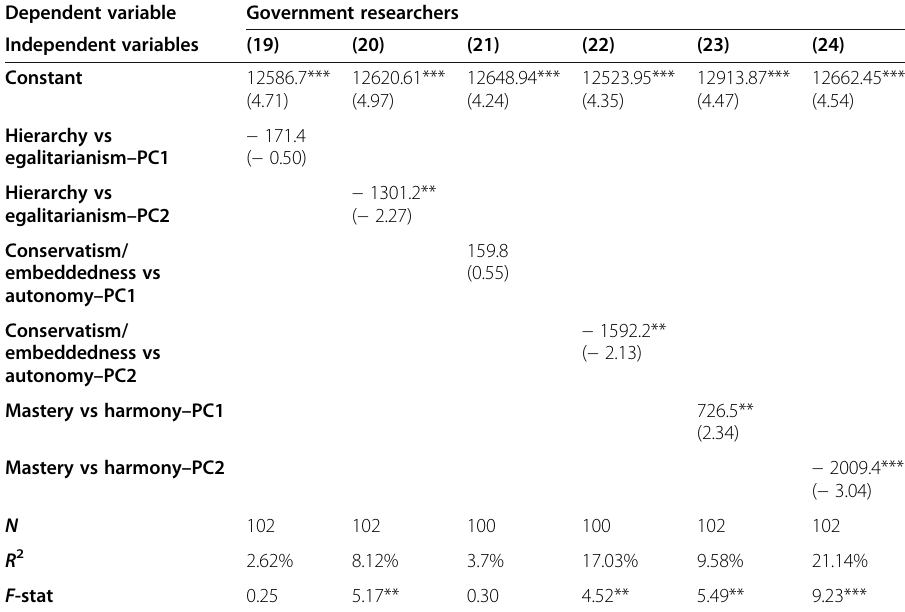
Table 13 The effect of culture on the number of government researchers Dependent